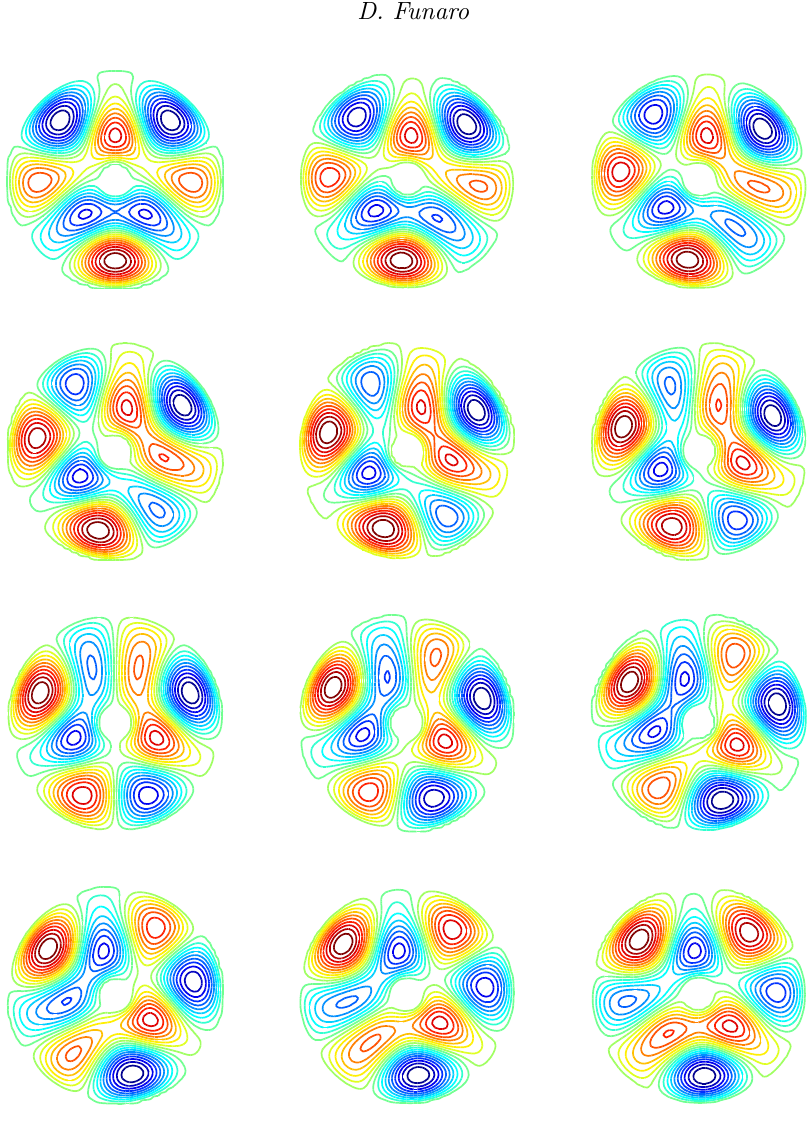
Figure 5. Evolution at different times of a linear combination of eigenfunctions corresponding to the same eigenvalue. The two eigenfunctions of Fig. 3 merge and rotate with an oscillating behavior. The frequency is uniquely established by the global size of the